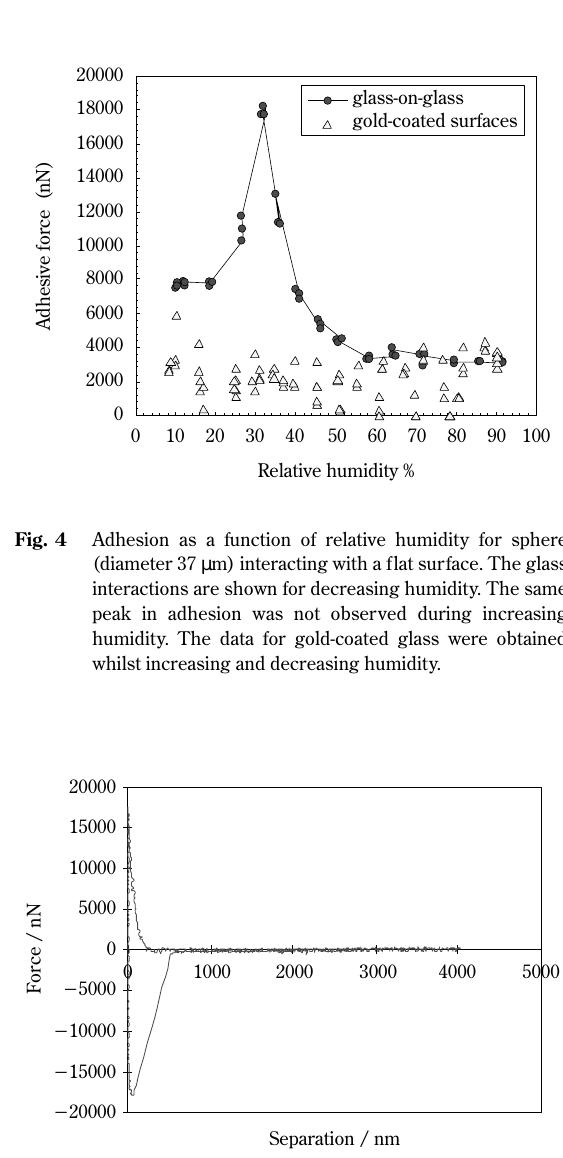
Fig. 5 Force-separation curve corresponding to the peak in adhe- sion shown in figure 4 for a 37- µ m-diameter glass sphere interacting with a flat glass surface. Note the repulsion (positive force) prior to rigid body contact occurring at a separation distance of between 200 and 300